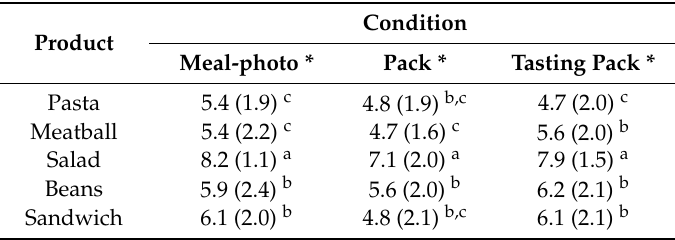
Table 5. Healthiness perception mean values, and the standard deviation in parentheses, of the five products evaluated on a plate (Meal-photo condition), in the pack (Pack alone condition) and after tasting with the packaging in view (Tasting-Pack alone condition).